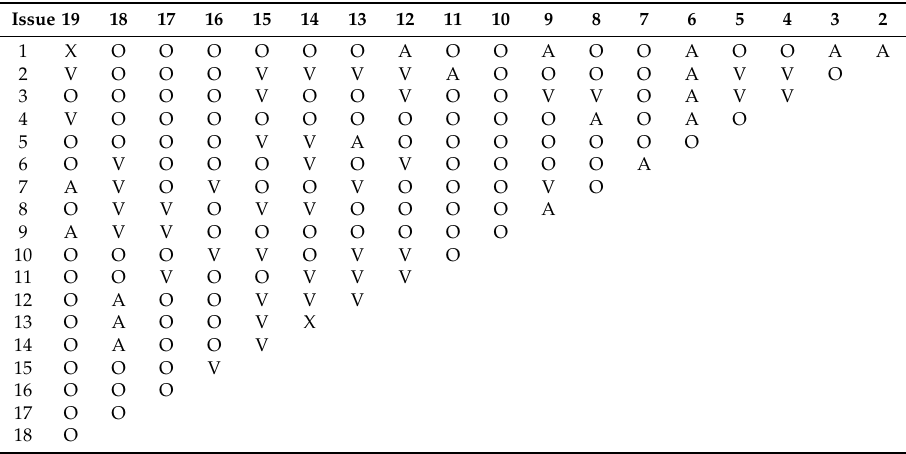
Table 2. Structural self-interactive